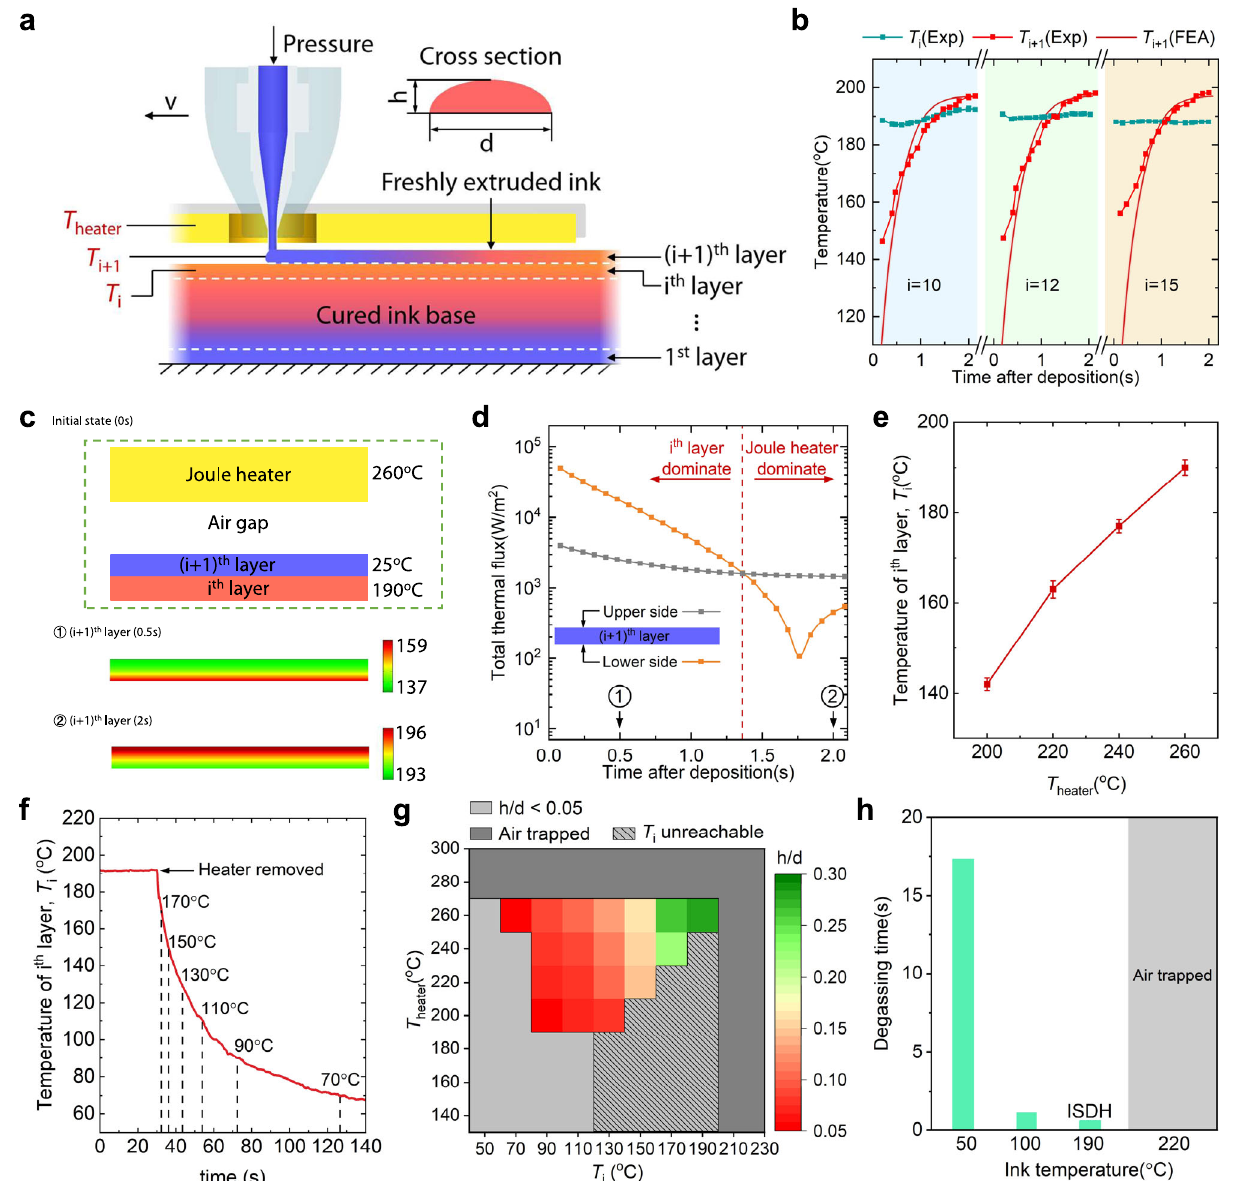
Fig. 2 | The mechanism of in situ dual heating. a Schematic illustration of ISDH. Thefreshlyextrudedinkislabeledas i +1 ð Þ th layerandthetoplayerofthecuredink baseislabeledas i th layer.ThetemperatureoftheJouleheater, i +1 ð Þ th layer,and i th layerisdenoted as T heater , T i+1 ,and T i , respectively. b Simulated degassing time at 50, 100, 190, and 220 °C. c Experimental and simulated temperature of freshly extruded ink when i =2, 5, 10. d Finite element analysis of the thermal fl ux on the